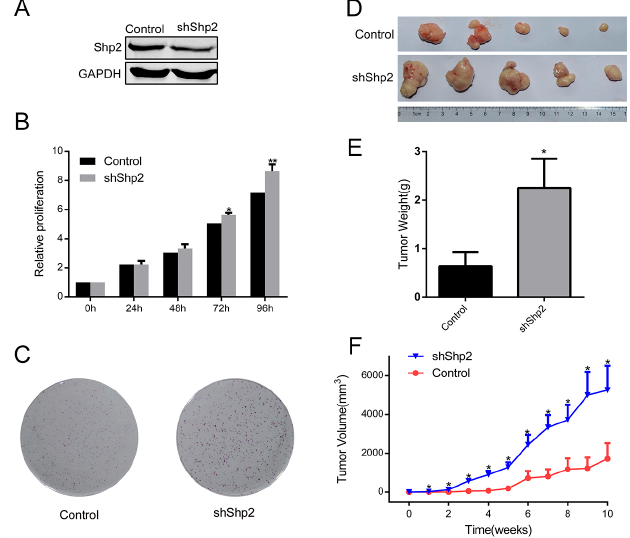
Figure 2. Shp2 knockdown enhances the proliferation of Eca109 cells in vitro and in vivo. ( A ) Eca109 cells were transfected with Shp2 shRNA or the matching control shRNA. The expression of Shp2 protein was analyzed by western blotting; ( B ) Proliferation of Eca109 shShp2 and control cells was evaluated by determining the cell viability by CCK8 Assay; ( C ) Representative images of cell colonies in control and shShp2 Eca109 cells; ( D ) Tumors derived from control versus shShp2 Eca109 cells at 10 weeks post inoculation are shown; ( E ) The weight of the tumor at 10 weeks was evaluated; ( F ) Tumor growth curves over 10 weeks are shown. (* p < 0.05, ** p < 0.01).